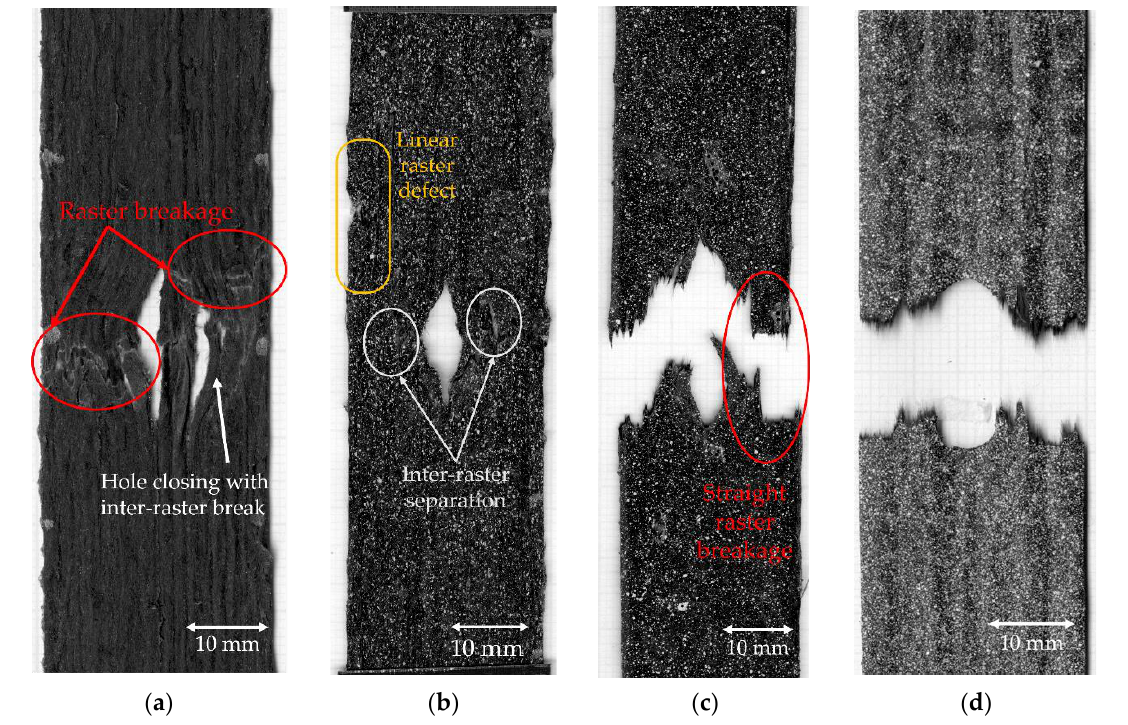
Figure 15. Breakage of the open-hole samples: ( a ) 10C showing hole closing by the inter-raster separation following raster breakage [25]; ( b ) 4C showing the raster separations with defect at the linear line that occurs before the breakage of the raster at the curvature area; ( c ) 4C-Oven showing the catastrophic failure in the rasters perpendicular to the load direction; ( d ) tape layup showing breakage perpendicular to the fibre/load direction at the middle of the hole [25].